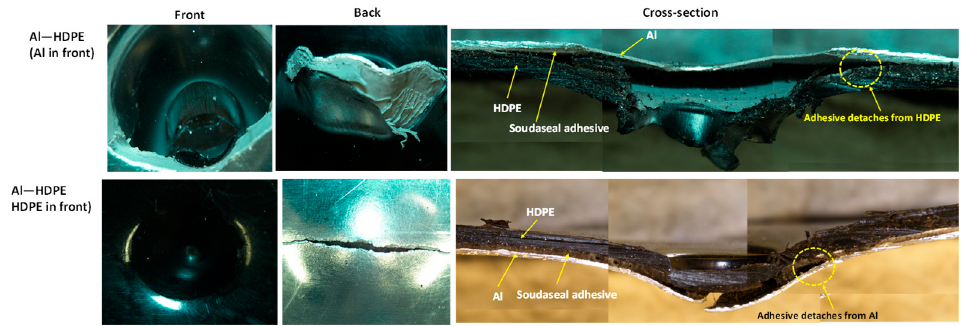
Figure 9. Failure modes of bilayer laminates under the conical indenter.